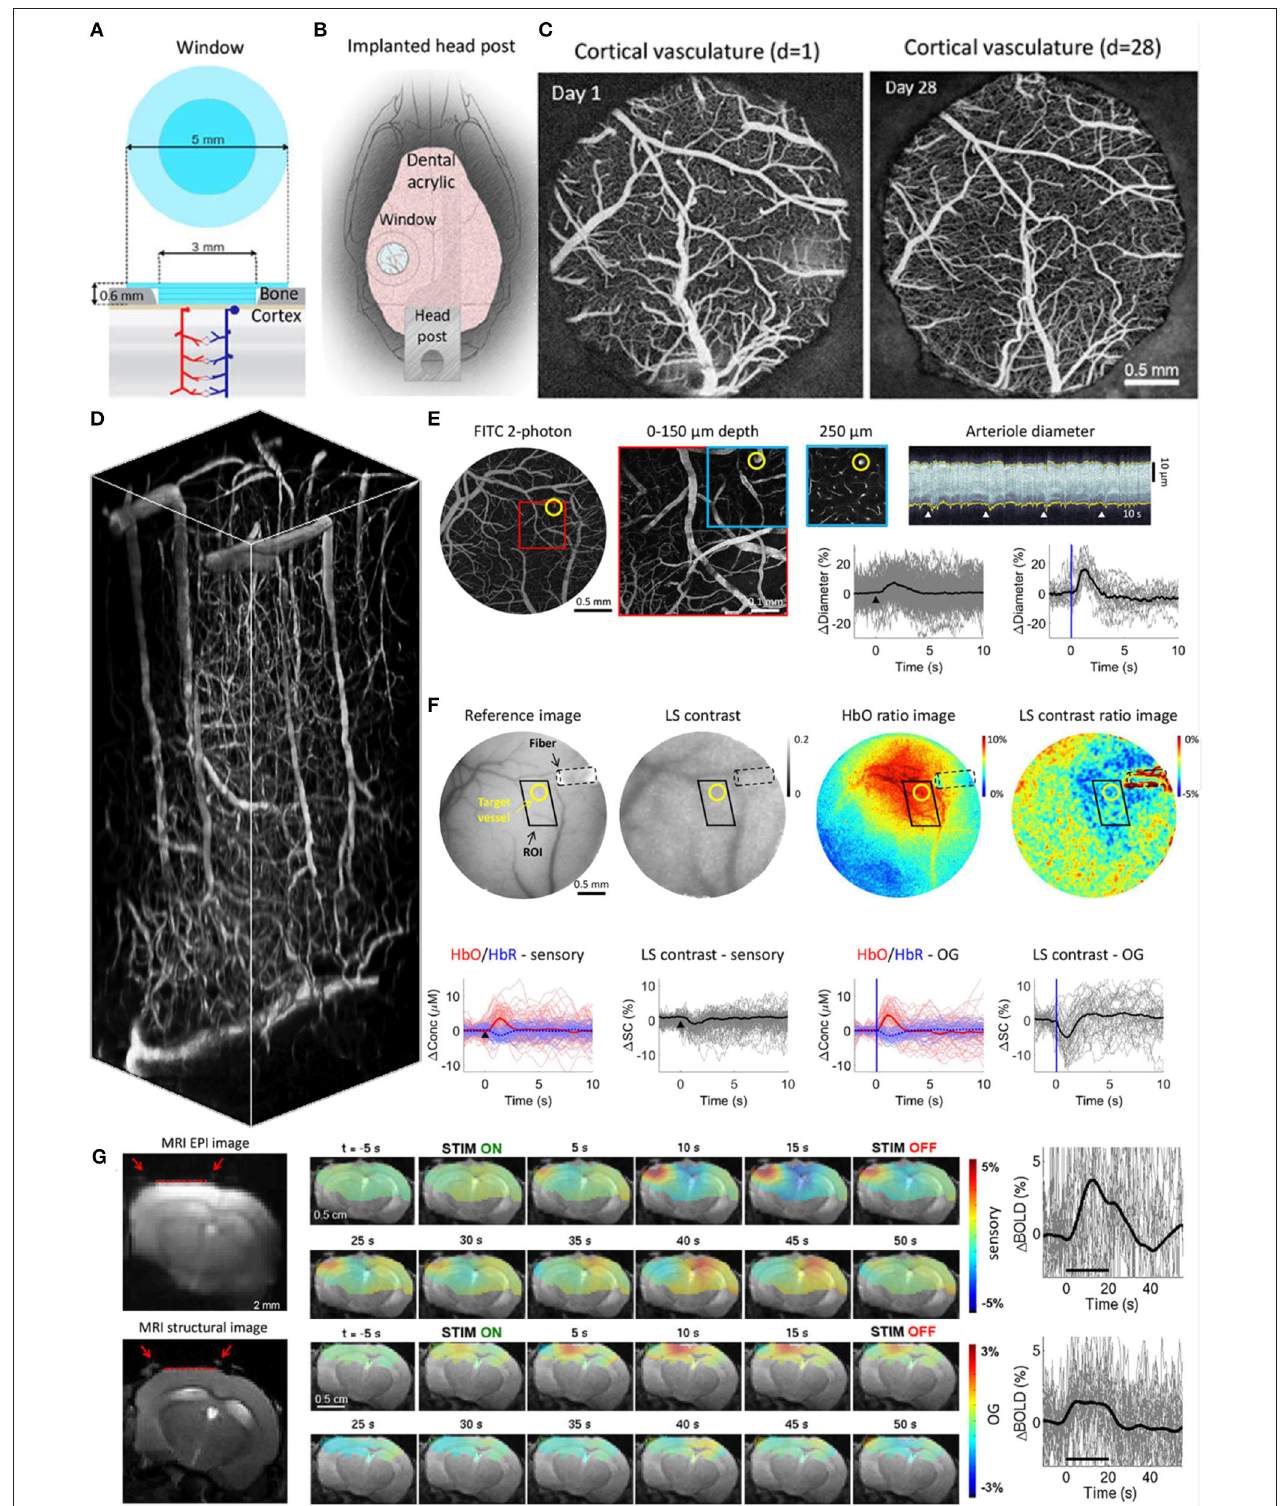
FIGURE 1 | (A) Schematics of the borosilicate glass window implant. (B) Schematic illustration of the window implant over the whisker representation within the primary somatosensory cortex (SI) and the headpost fixed to the skull overlaying the other (contralateral) hemisphere. (C) Images of the brain vasculature through